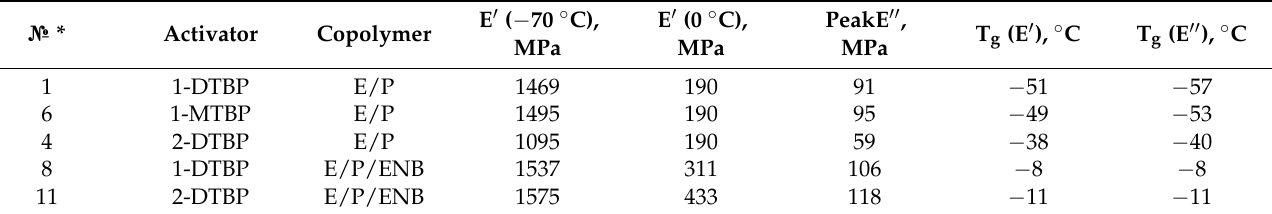
Figure 4. Temperature dependencies (at 1 Hz) of E ′ ( a ) and E ″ ( b ) for E/P copolymers obtained on catalytic systems with mono- and dimeric aryl oxides (1) 1-DTBP, (6) 1-MTBP, (4) 2-DTBP, and E/P/ENB terpolymers obtained on catalytic systems with (8) 1-DTBP and (11) 2-DTBP. * Numbers on the curves match the entries in Tables 1 and 3. Table 3. DMA data for E/P and E/P/ENB copolymers.